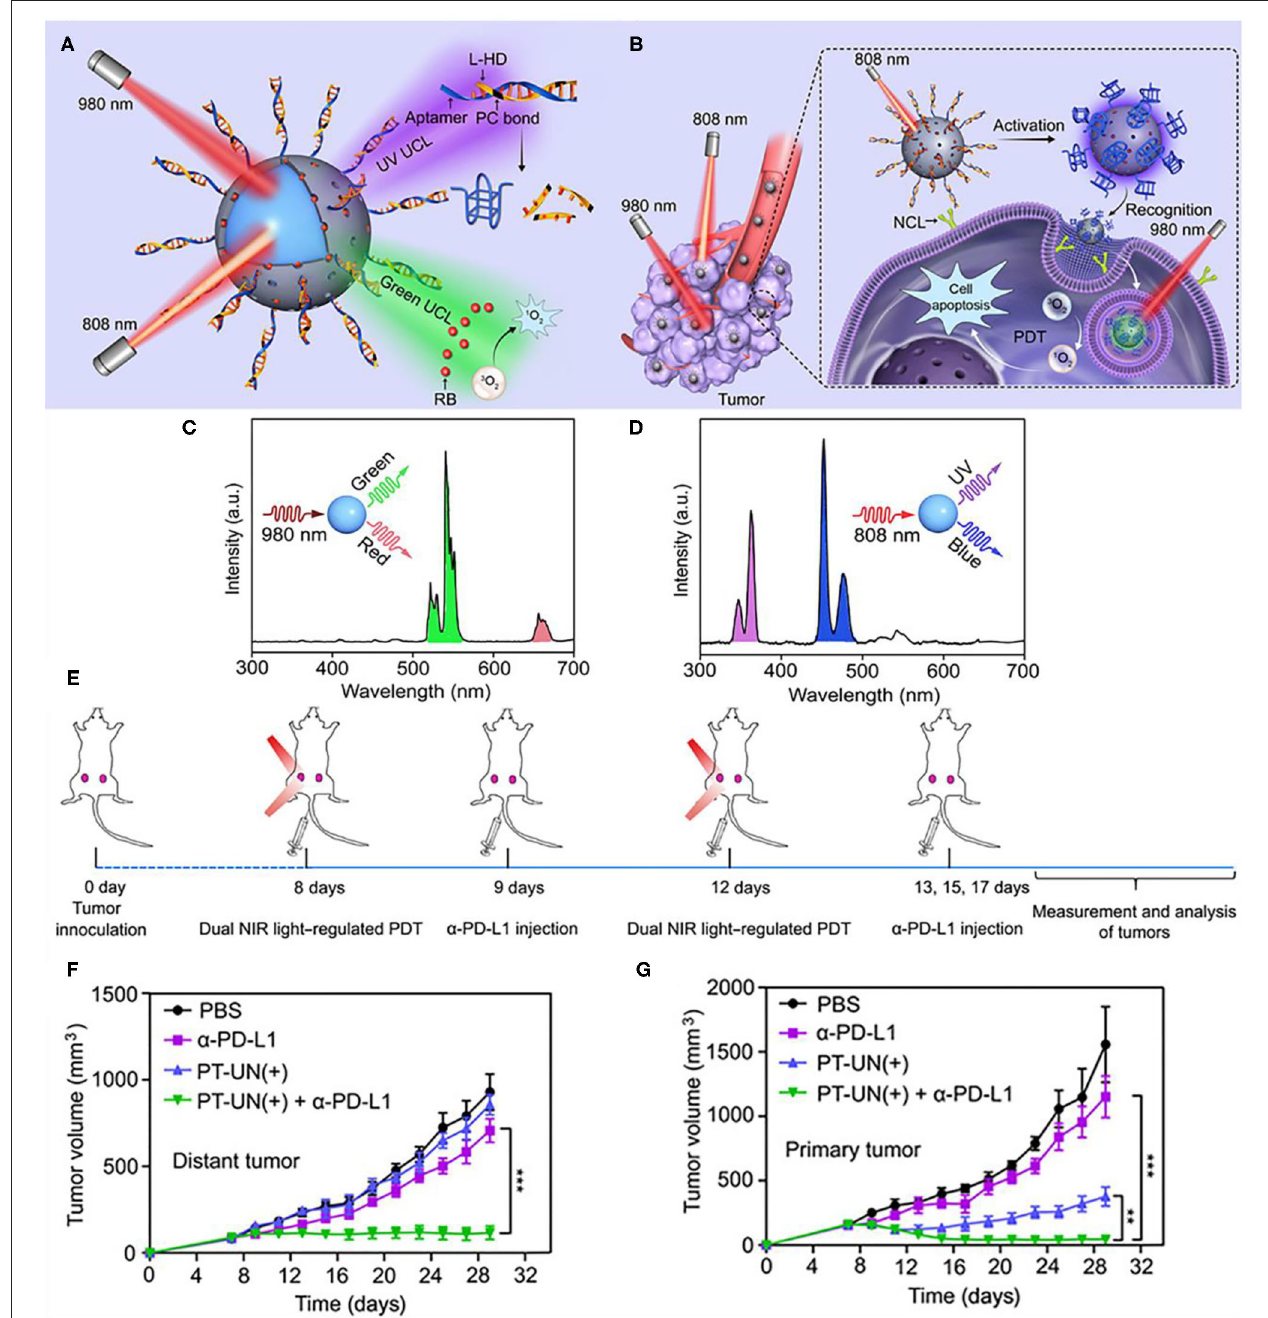
FIGURE 10 | Schematic showing the orthogonal regulation of DNA nanodevice for programmed tumor cell recognition and treatment. (A) The orthogonal photoactivation behavior of the DNA nanodevice in response to two NIR light of different wavelengths. (B) Sequential activation of the nanodevice with orthogonal UCL for programmed tumor recognition and PDT. UCL spectra of the core-multishell UCNPs upon excitation of 808 (C) and 980nm (D) . (E) Schematic illustration of combining PT-UN( + ) with α -PD-L1 therapy to inhibit tumor growth at both primary and distant sites. Tumor growth curves of primary tumors (F) and distant tumors (G) of bilateral tumor-bearing mice with different treatments. Data are means ± SD ( n = 5). Copyright 2020, American Association for the Advancement of Science (Di et al., 2020). ** P < 0.01, *** P < 0.001.